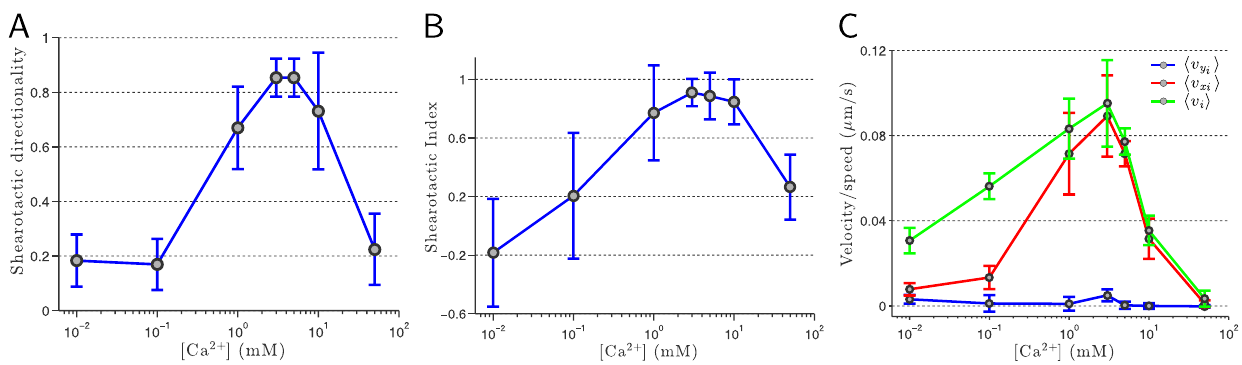
Figure 3. Influence of the extracellular calcium concentration on the shearotactic cellular response. (A) S d . (B) S i . (C) Average cell speed T (resp. S u y T ) for a shearotactic signal pointing toward the positive x S u i T , average x -component (resp. y -component) of the cell velocity S u x i i direction. At both ends of the calcium concentration range considered, the shearotactic efficiency is extremely poor as attested by the values of S d and S i . A high shearotactic efficiency is achieved for calcium concentrations in the 1–3 mM range. For the speed, a clear maximum is attained for a concentration of 3 mM. The optimal shear stress level of s ~ 0.18 Pa is considered for the seven different values of the external calcium concentration. A log-scale is used for the calcium concentration on the x -axis and for each value of [Ca 2 + ] ext the averaging process is based on a population comprising between 60 to 135 individual tracked cells for a duration of 1,200 seconds and with a sampling time of 15 seconds. Cells are crawling over a plastic hydrophobic surface.